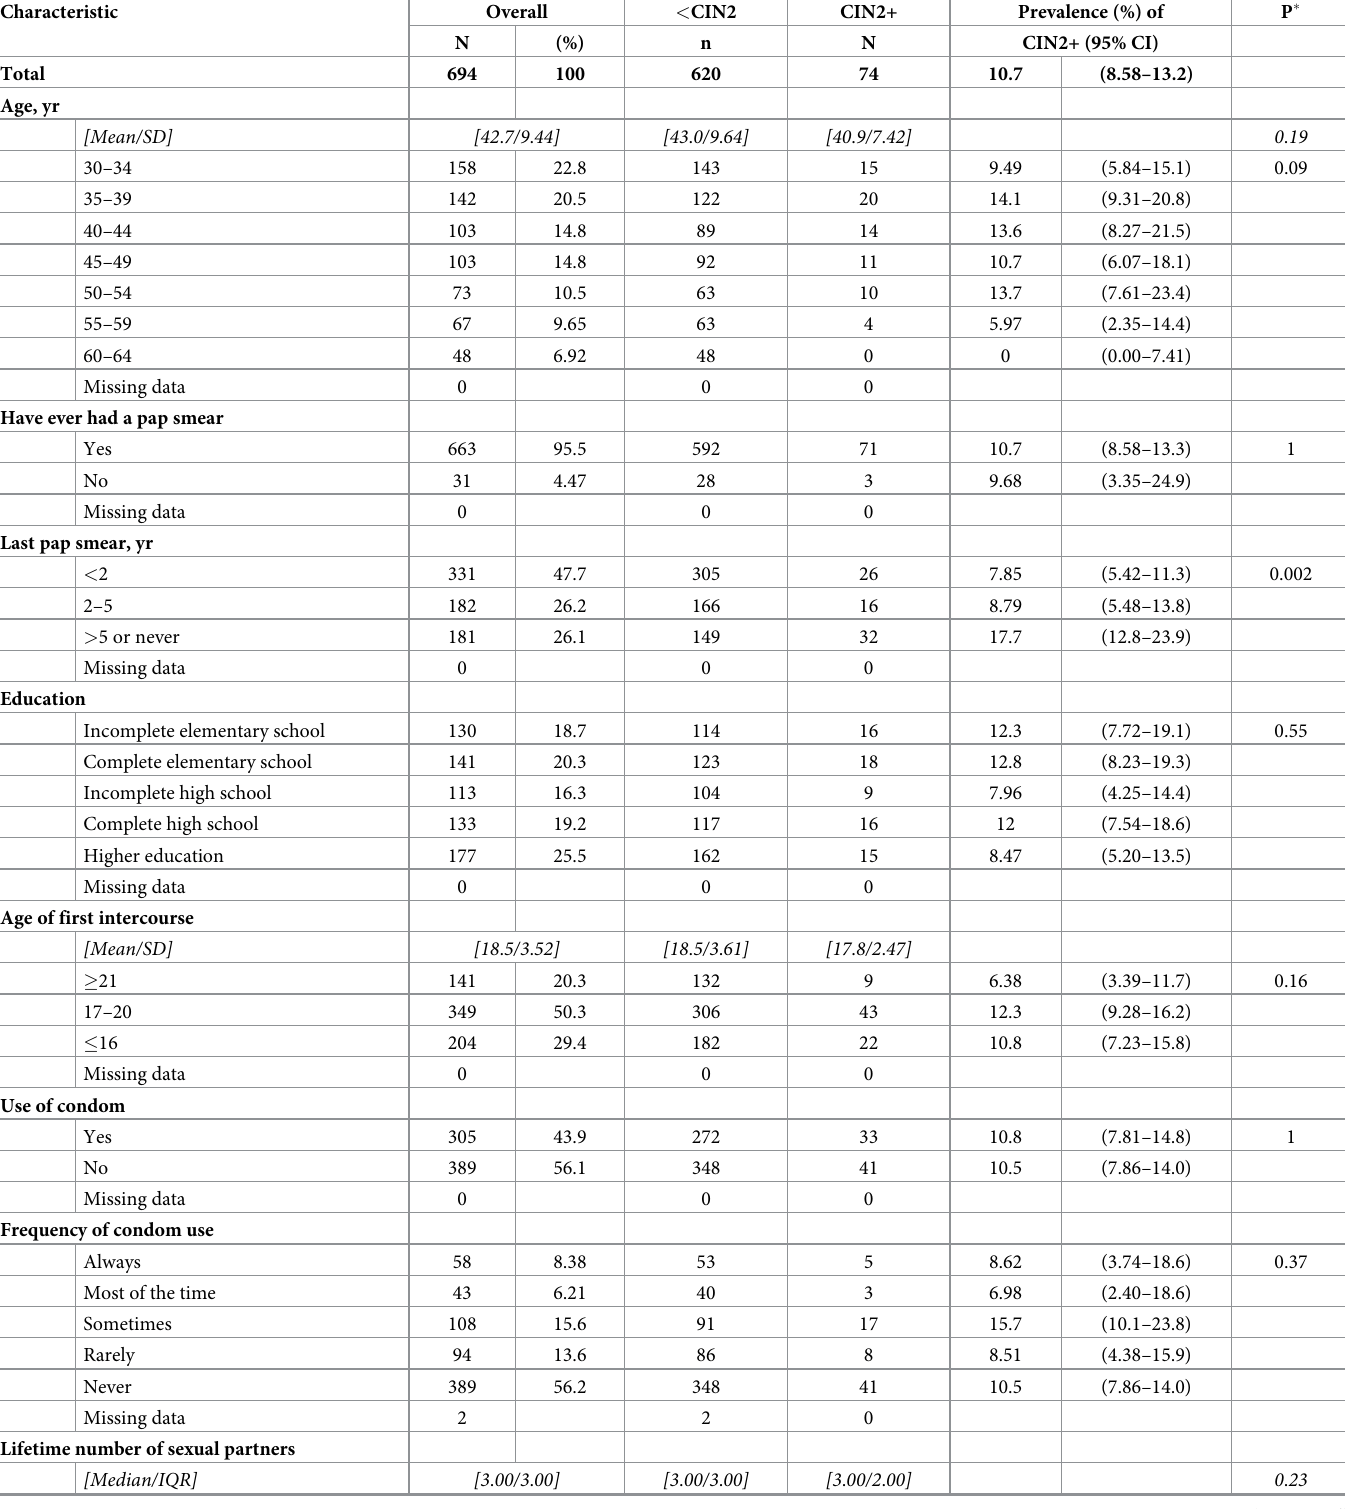
Table 2. Characteristics and prevalence of CIN2+ in 30-69-year-old hrHPV+ women with histopathological diagnosis from the Central Department, Paraguay.